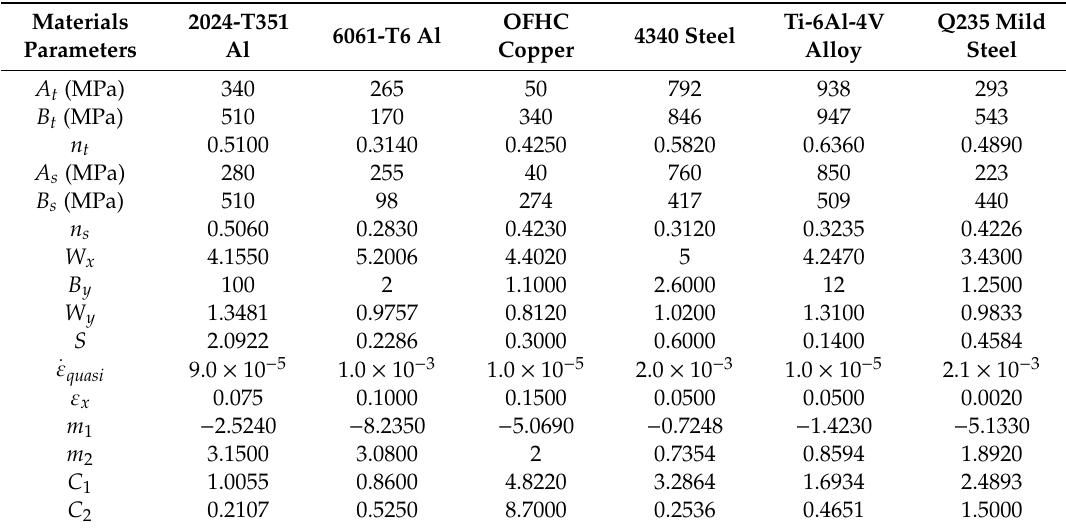
Table 1. Values of constants in the new constitutive model and new fracture